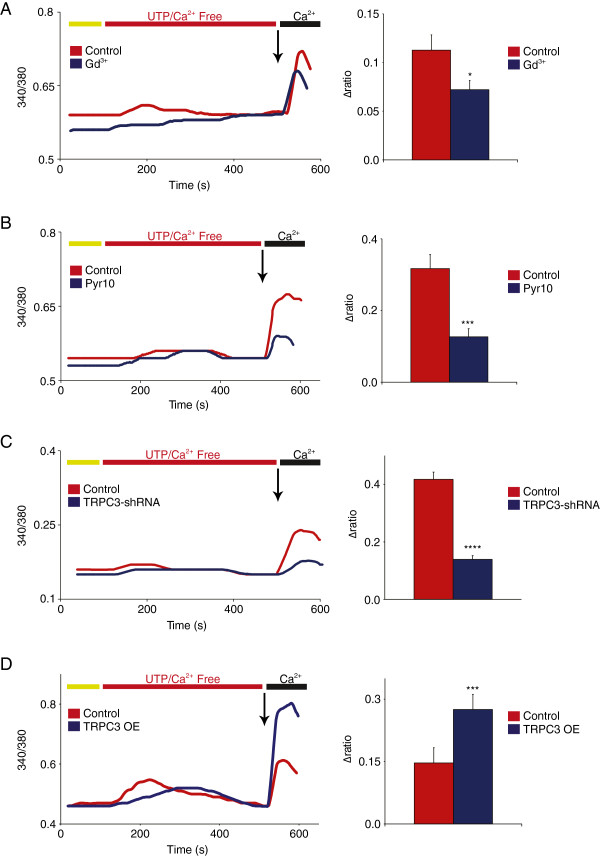
Functional coupling between TRPC3 and UTP/P2Y2 signaling in DRG neurons. (A) The addition of 100 μM UTP for 7 minutes to the calcium-free perfusion solution activates P2Y2 receptors, which initiate both SOCE and ROCE responses. The addition of Gd3+ removes the Orai component of the UTP-evoked response, which accounts for approximately 35% of the overall calcium influx (n = 17-19, P < 0.05). (B) The blockade of TRPC3 specifically with Pyr10 (10 μM, 15 min) resulted in a drastic decrease of UTP-evoked calcium entry, resulting in 60% inhibition (n = 25-28, P < 0.001). (C) shRNA-mediated knockdown of TRPC3 induced in similar decrease of P2Y2-mediated calcium entry (n = 34-46, P < 0.0001). (D) Heterologous overexpression of TRPC3 (OE) resulted in 90% increase of calcium influx in the UTP response, indicating a strong link between TRPC3 activity and P2Y2 transduction (n = 24-45, P < 0.001).